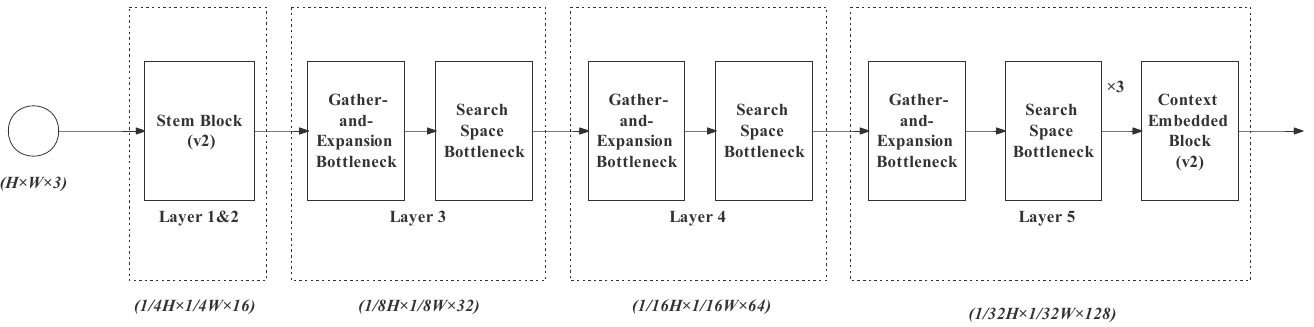
Figure 14. Network for search-space bottleneck